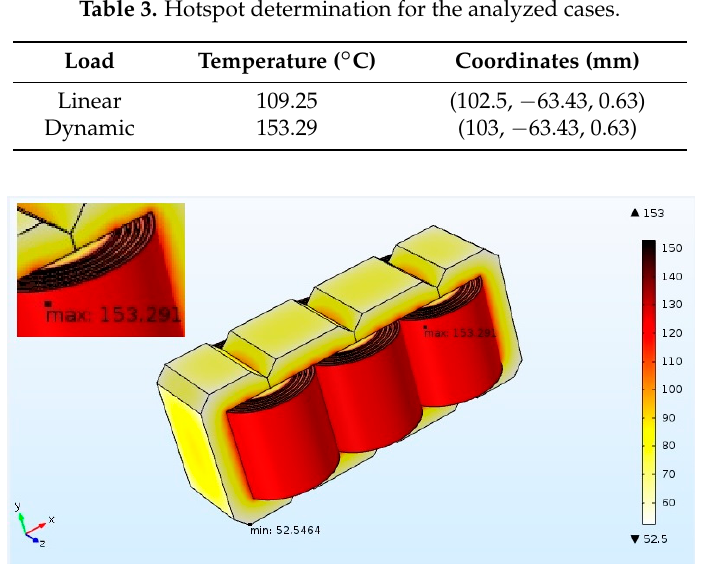
Figure 10. Thermal field and hotspot location for the dynamic case.